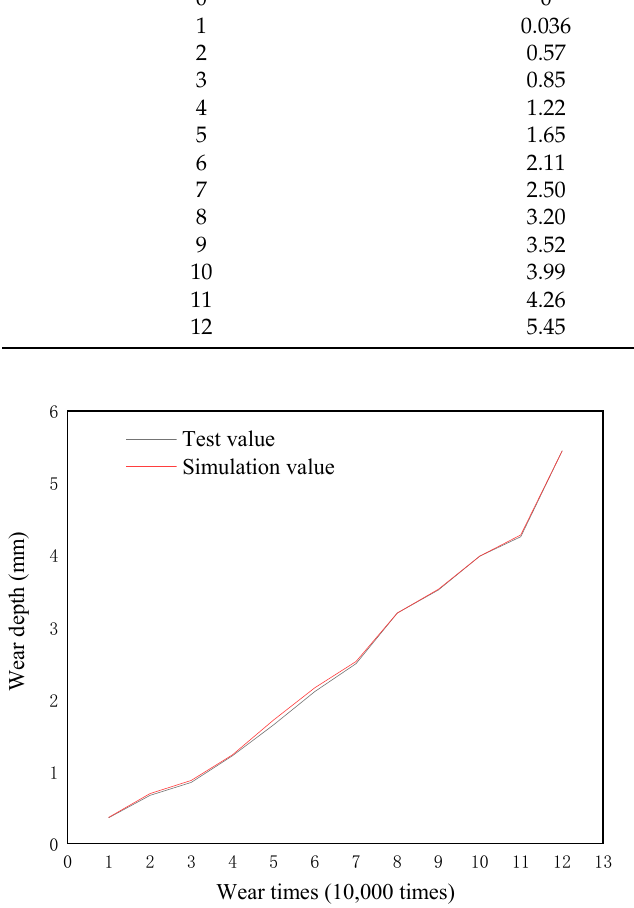
Figure 13. Comparison of wear depth between test values and simulation values.